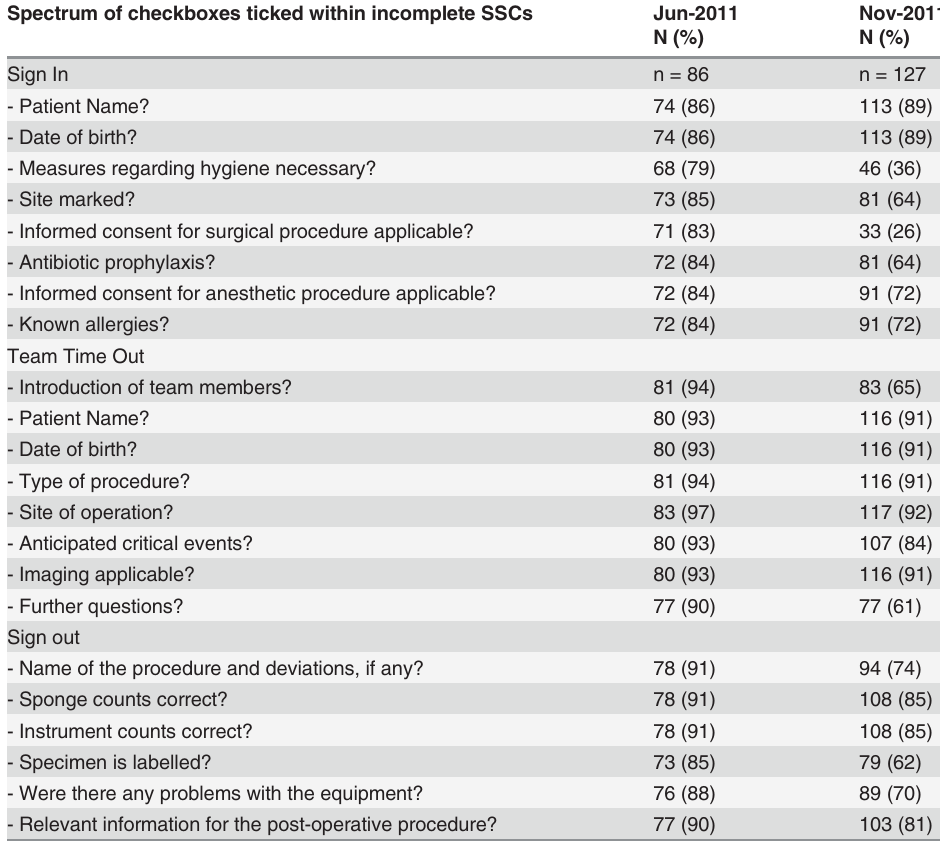
Table 2. Quantitative analyses of compliance in partially completed SSCs during test run 1 and 2. Spectrum of checkboxes ticked within incomplete